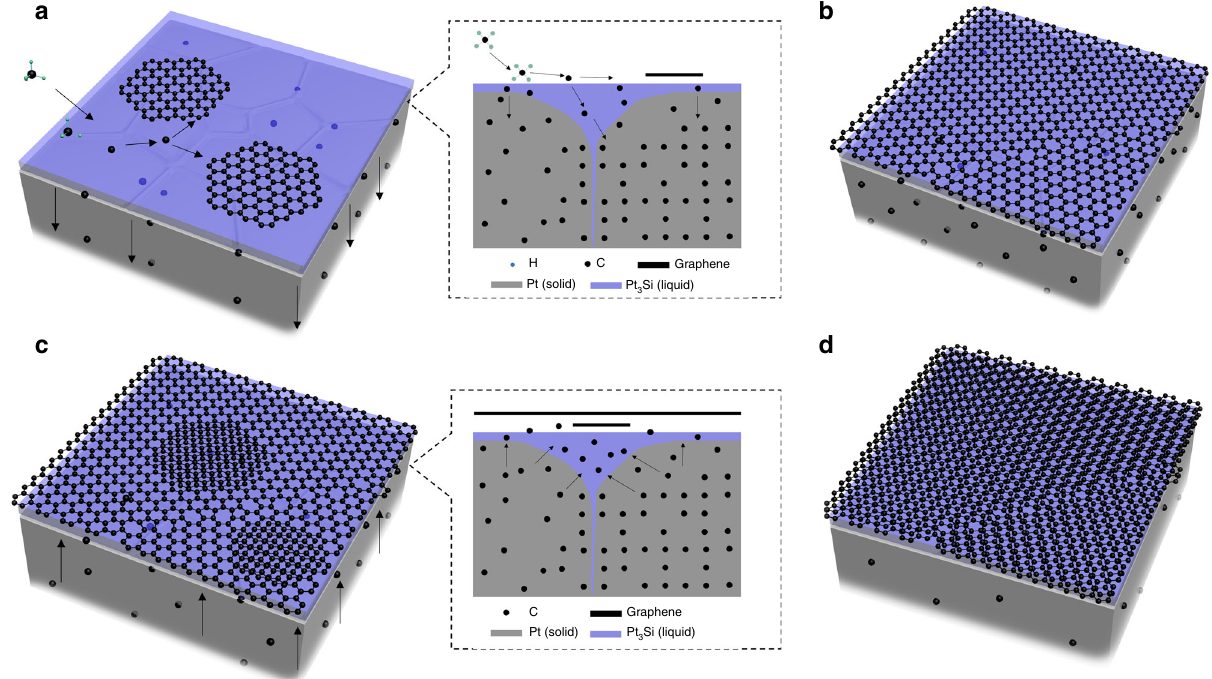
Fig. 5 Schematic for the interlayer epitaxial growth of AB-BLG fi lm on liquid Pt 3 Si/solid Pt substrate. a The growth of isolated MLG domains in the constant-temperature step. During this process, the excess carbon atoms diffuse through the liquid Pt 3 Si shell into the solid Pt core. b The formation of a continuous MLG fi lm by merging of the expanded domains. c Interlayer epitaxy of isolated second layer domains underneath the pre-formed MLG during slow-cooling process, through the precipitation of the dissolved carbon atoms in the fi rst step. d The formation of continuous uniform AB-BLG through the expansion and merging of the second layer domains with continuous supply of the dissolved carbon atoms. Insets in ( a ) and ( c ) are the schematic cross sections. In ( c ) and ( d ), CH 4 supply is maintained to prevent H 2 etching of the pre-formed